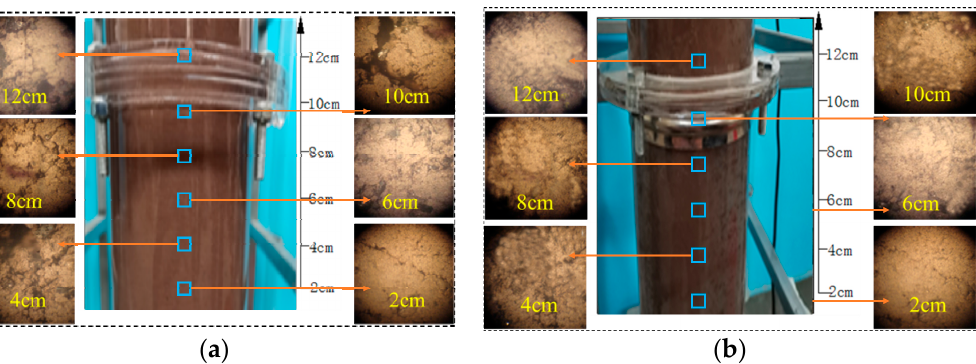
Figure 6. Tailings beds and image acquisition. ( a ) Distribution of the nonshear tailings bed. ( b ) Distribution of the shear tailings bed.